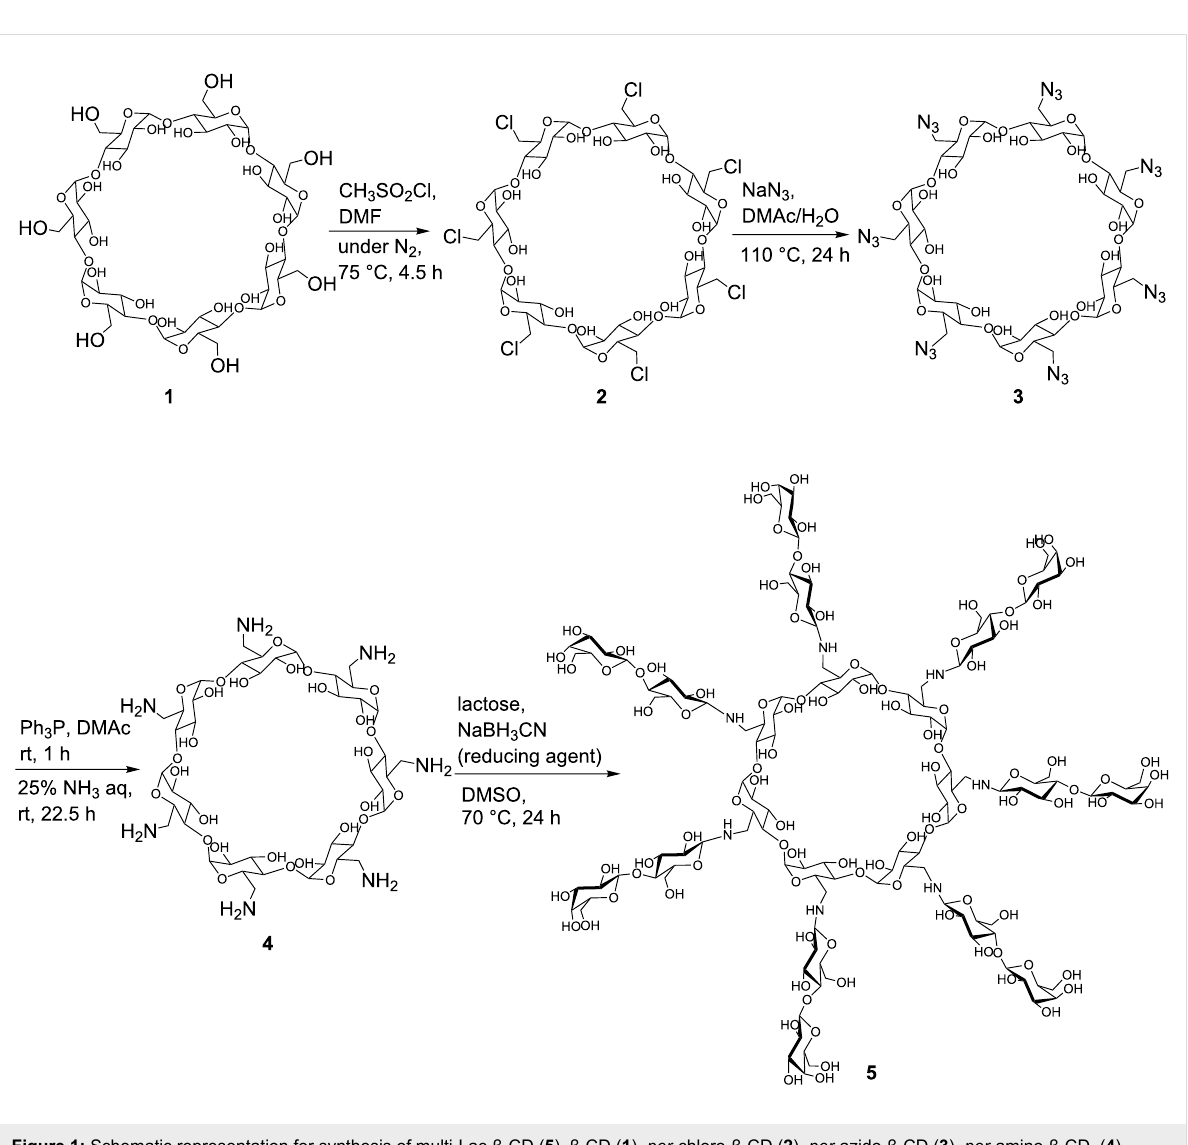
Figure 1: Schematic representation for synthesis of multi-Lac- β -CD ( 5 ), β -CD ( 1 ), per -chloro- β -CD ( 2 ), per -azido- β -CD ( 3 ), per -amino- β -CD, ( 4 ), multi-Lac- β -CD (DSL5.6), DSL, degree of substitution of lactose, DMAc, dimethylacetamide.